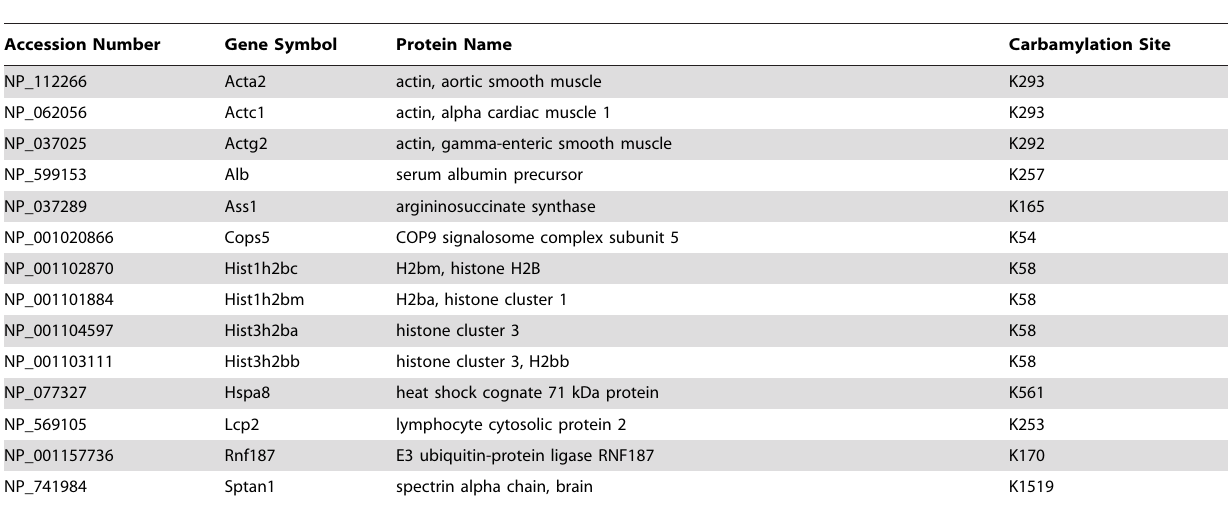
Table 2. Identified carbamylation sites that have been previously shown to be ubiquitylated according to PhosphoSite Plus